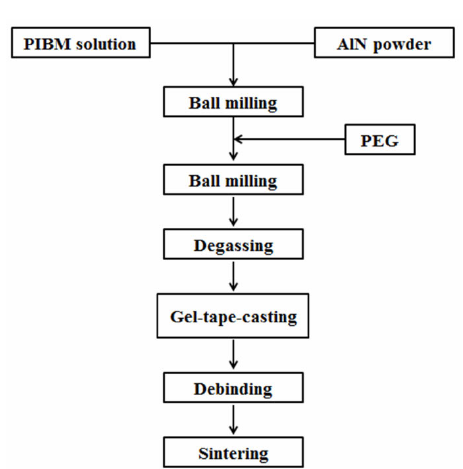
Fig. 2 Flowchart of the gel-tape-casting